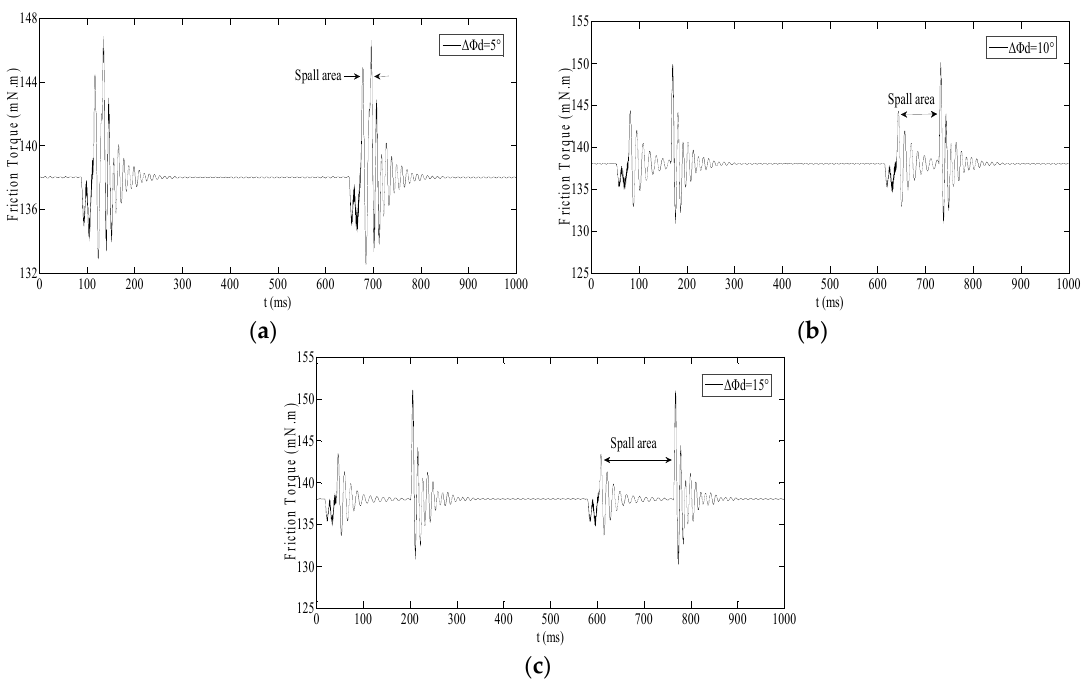
Figure 6. The friction torque for different spall length: ( a ) Δ Φ d =5°; ( b ) Δ Φ d =10°; ( c ) Δ Φ d